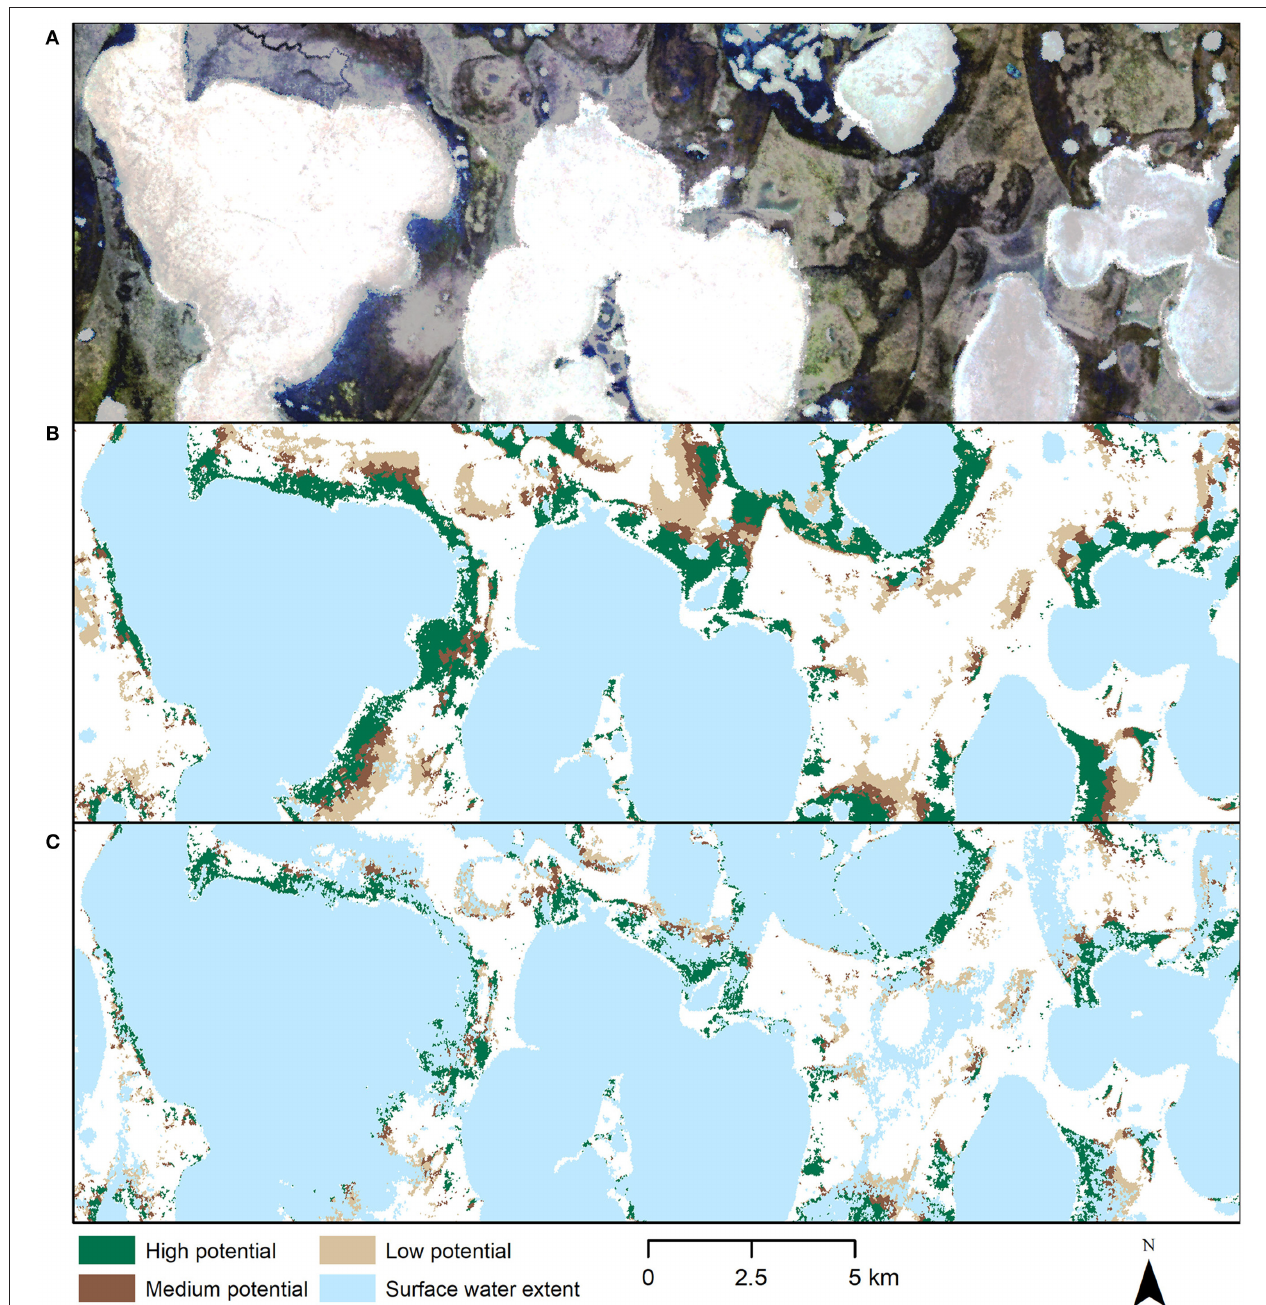
FIGURE 4 | (A) Subset of the Indigirka Siberian crane core breeding area (true color Landsat 8 median composite June 2013-2018). Large white areas are snow or ice covered lakes, darker areas are typical of wetlands, lighter areas are typical of other vegetation types. (B) Potential nesting habitat at multiannual average June surface water extent. (C) Potential nesting habitat at maximum flood extent. Over the entire study area, suitable nesting habitat availability decreases by about 53% during an extreme flooding event.